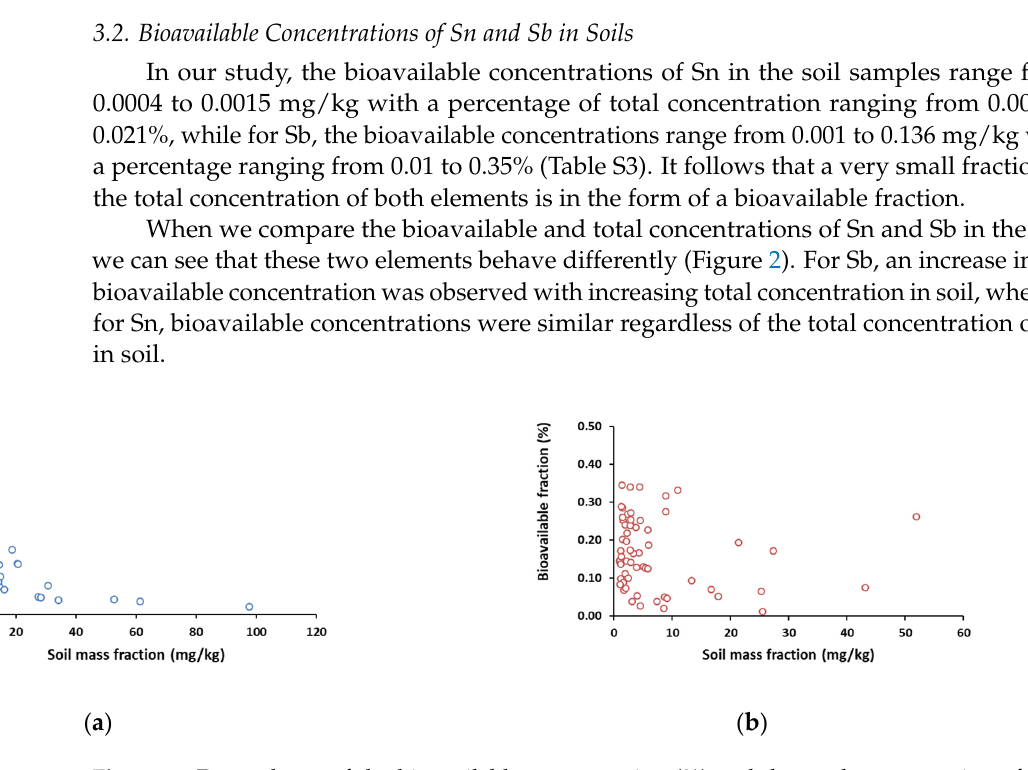
Figure 2. Dependence of the bioavailable concentration (%) and the total concentration of each element in the soil for ( a ) Sn, and ( b ) Sb.